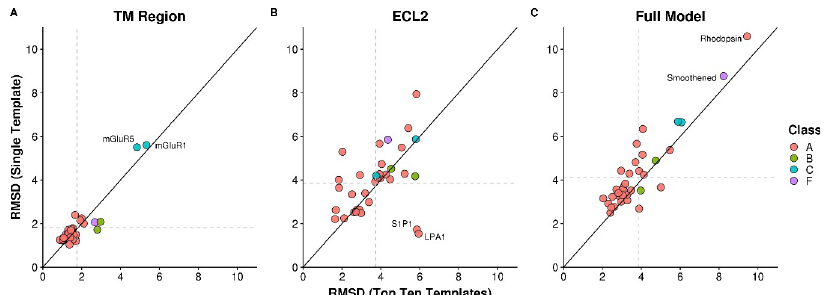
Fig 3. Comparison of average RMSDs for single versus multiple template homology modeling. Using either one template or ten templates, 1000 models were generated for each target and the average RMSD was calculated over the TM region (A), ECL2 (B), and the full model (C). Values that fall above the diagonal performed better when using multiple templates and values that fall below the diagonal performed better with a single template. Targets are colored by class.